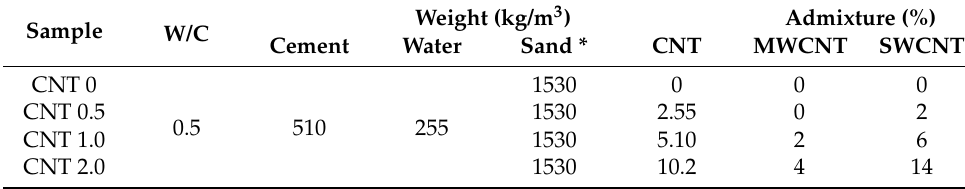
Table 3. Particle size distribution of standard sand (KS L ISO 679 [53]).